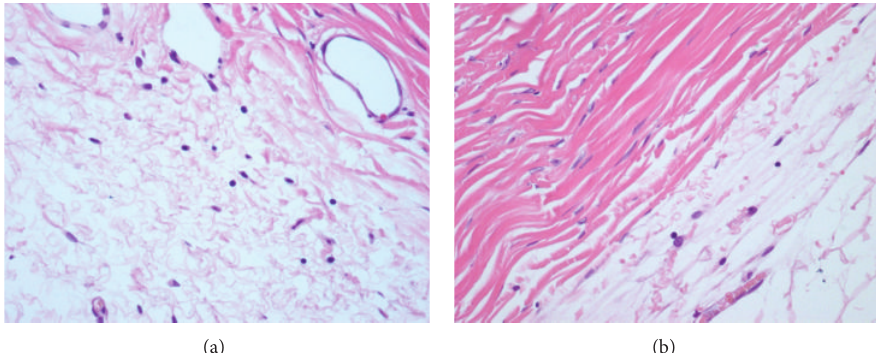
Figure 1: Grade 1 inflammation (presence of lymphocytes) in a control eye (a) and an AM eye (b) with H&E stain and 400x magnification.